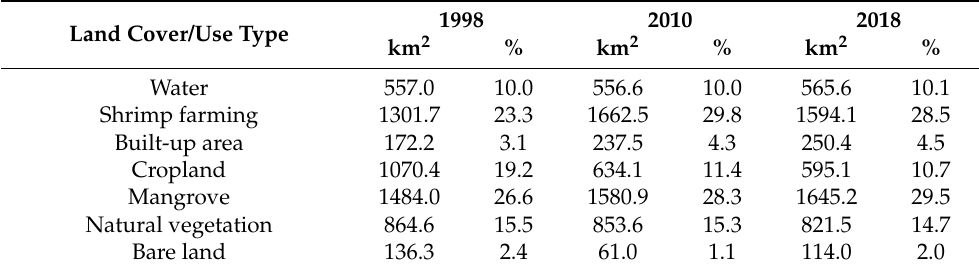
Table 6. Changes in land cover and use-type cover in the three study